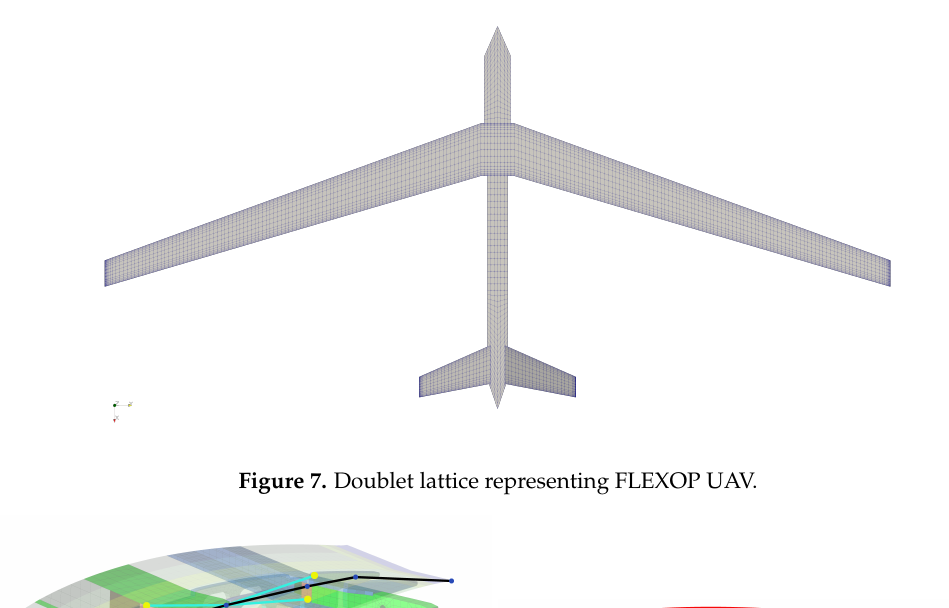
Figure 8. Aero-structural load interface.